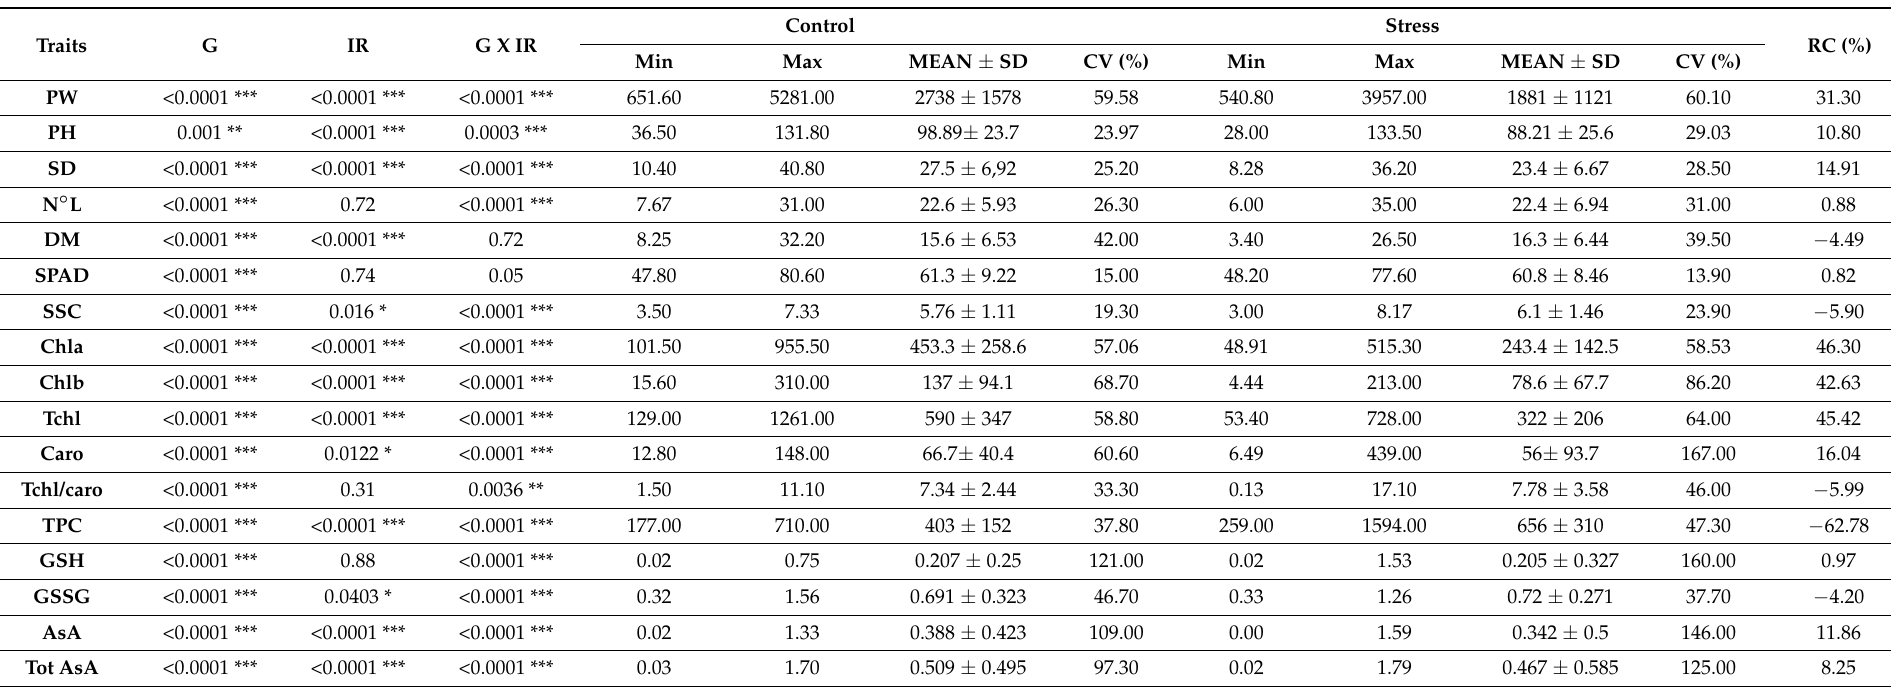
Table 3. Analysis of variance (ANOVA) and summary statistics for measured morphological and physio-biochemical traits of 20 Brassica oleracea accessions evaluated under control and